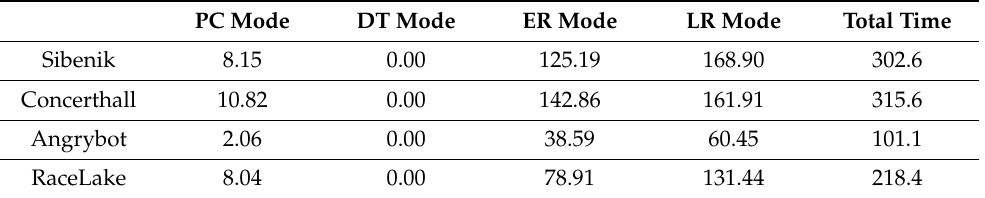
Table 1. Performance by modes of single-threaded sound propagation algorithm for eight sound sources (frame time: ms).